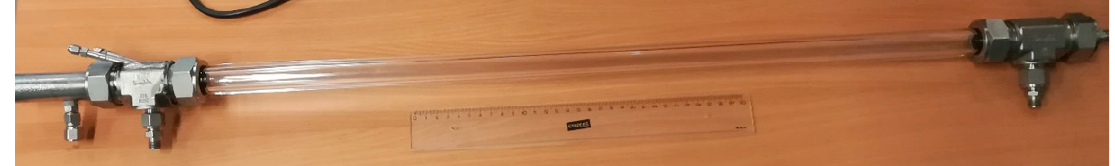
Figure 3. Picture of the empty reactor used to carry out the experiments.